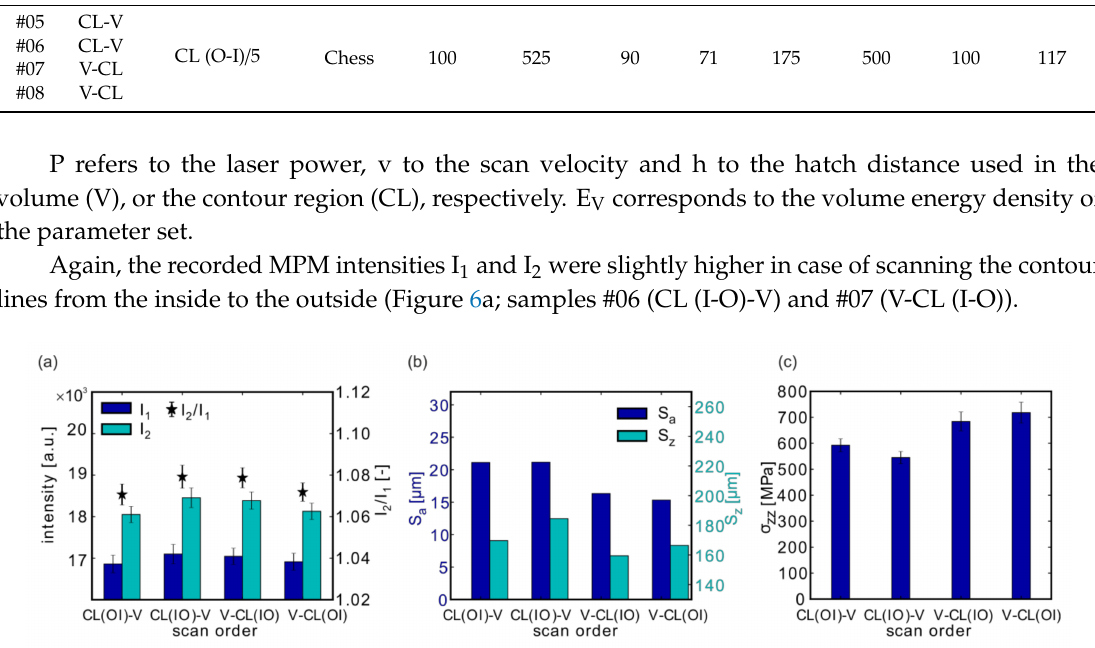
Figure 6. Influence of the scan order on the MPM data ( a ), on the surface roughness ( b ), and on the residual stresses ( c ). Depicted are the results from samples #05 (CL(O-I)-V), #06 (CL(I-O)-V), #07 (V-CL(I-O)), and #08